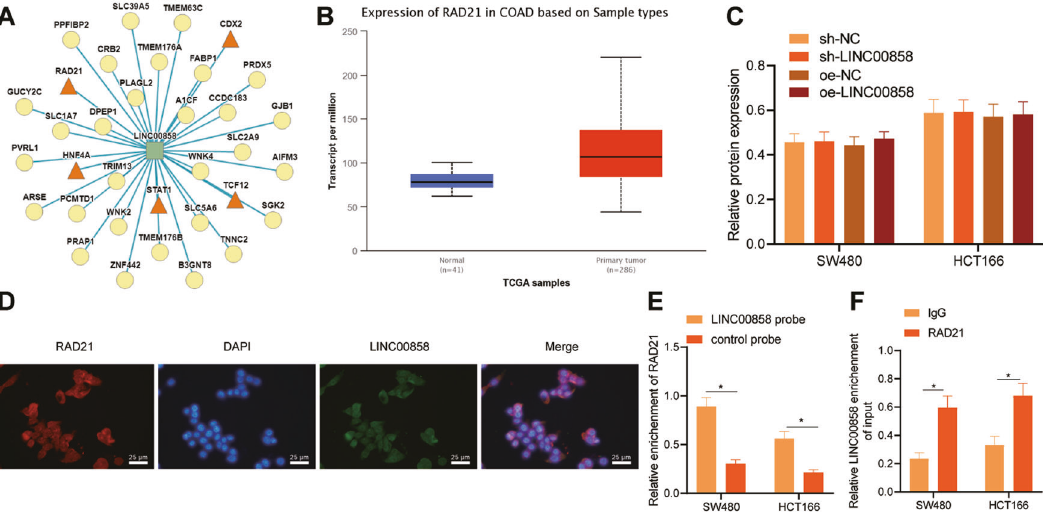
Fig. 2 LINC00858 recruits RAD21 in colon cancer cells. A LncMAP predicted the possible binding proteins of LINC00858, among which LINC00858 interacted with RAD21, TCFL2, STAT1, CDX2, and HNF4A. B The RAD21 expression in colon cancer detected by UALCAN. C The expression of RAD21 in SW480 and HCT166 cells determined by Western blot assay. D The co-localization of LINC00858 and RAD21 in SW480 cells detected by RNA-FISH. E The interaction between LINC00858 and RAD21 detected by RNA pull down assay. F The interaction between LINC00858 and RAD21 detected by RIP. * p < 0.05. Data from multiple groups were compared using one-way ANOVA with Tukey ’ s post hoc tests. All cell experiments were repeated three